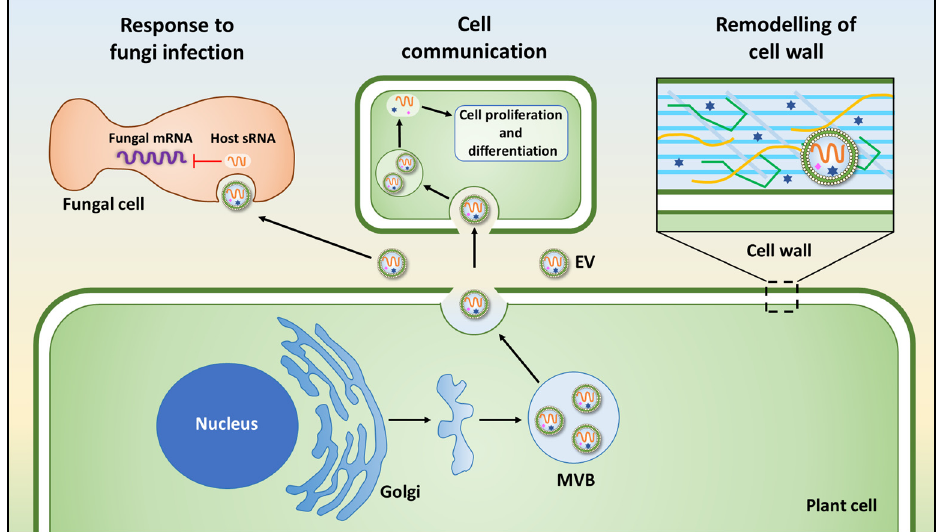
Figure 2. The physiological roles of plant-derived extracellular vesicles. The main functions of PDEVs are (i) response to fungi infection; (ii) cell–cell communication; (iii) cell wall remodeling. EV, extracellular vesicle; MVB, multivesicular body; sRNA, short RNA, mRNA, messenger RNA.